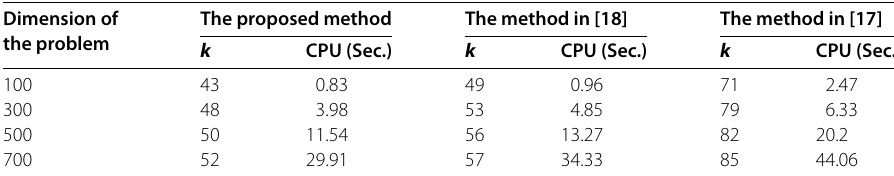
Table 1 Numerical results for problem (4.1) with r 1 = 0.5, r 2 = 5 Dimension of the problem